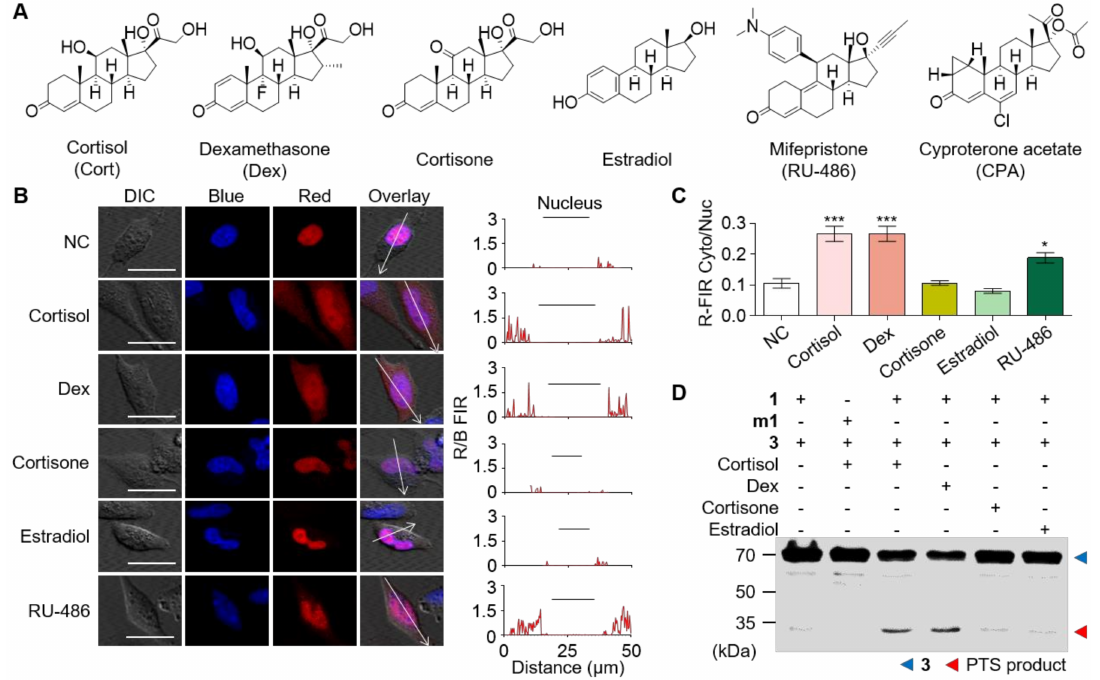
Figure 3. Discrimination of GR effectors from structural analogues of cortisol using the sensor cells. ( A ) The structures of cortisol and structural analogues are presented. Dexamethasone (Dex), mifepristone (RU-486), and cyproterone acetate (CPA) are an agonist, an active antagonist, and a passive antagonist of GR, respectively. Cortisone and estradiol are structural analogues of cortisol without GR binding activity; ( B ) the sensor cells responded to cortisol and the agonist and active antagonist of GR and discriminated the structural analogues (scale bar = 25 µ m); ( C ) the R-FIR Cyto/Nuc are calculated (* p < 0.05 and *** p < 0.001). ( D ) The western blot analysis shows the formation of covalently conjugated active signal peptide when sensor cells are challenged with cortisol or its functional analogues.